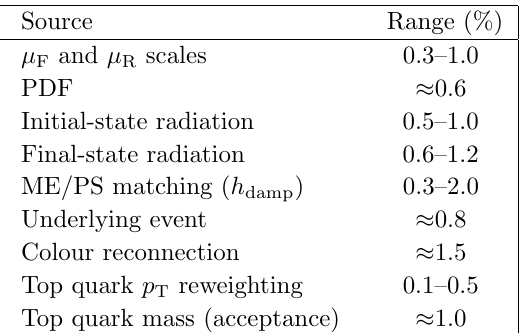
Table 1 . Summary of the uncertainties on the M T2 distribution resulting from tt background modelling uncertainties. The ranges correspond to variations of the uncertainty along the M T2 distribution. When only one number is shown, the uncertainty is approximately constant over the entire M T2